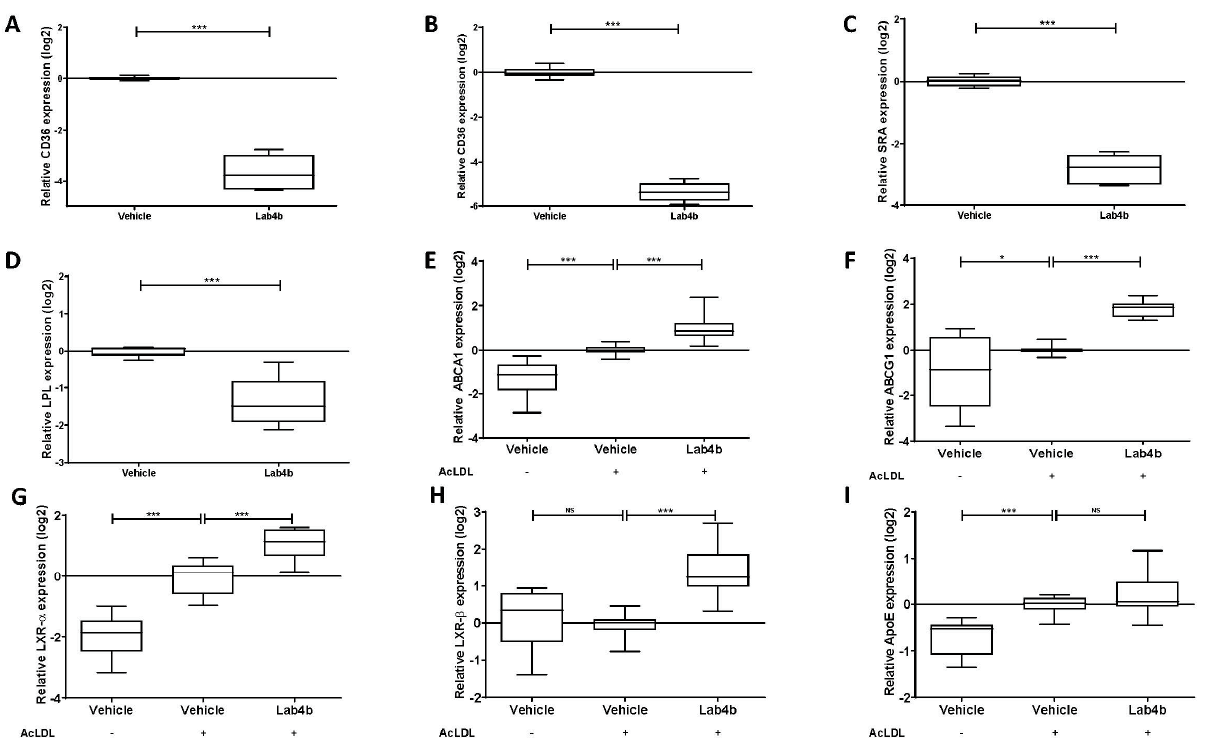
Figure 4. Lab4b CM regulates the expression of several key genes implicated in the control of macrophage foam cell formation. THP-1 macrophages ( A , C , D ), HMDM ( B ) or THP-1 macrophage- derived foam cells using acetylated LDL (AcLDL, 25 µ g/mL; E – I ) treatment for 24 h were incubated for 24 h with vehicle or Lab4b CM (1.5 µ g/mL). For THP-1 macrophage-derived foam cells ( F – I ), cells treated with vehicle alone in the absence any AcLDL treatment were also included for comparative purposes. The expression of CD36 ( A , B ), SRA ( C ), LPL ( D ), ABCA1 ( E ), ABCG1 ( F ), LXR- α ( G ), LXR- β ( H ), and ApoE ( I ) was determined on purified RNA by real-time quantitative PCR (RT- qPCR), as described in Materials and Methods, and normalised to the glyceraldehyde 3-phosphate dehydrogenase (GAPDH) housekeeping gene. The data are presented as box-and-whisker plots of log2 fold-change in gene expression relative to the vehicle control, where whiskers represent minimum-to-maximum fold-change from three independent experiments. Statistical analysis was performed using an unpaired Welch’s t -test ( A , C , D ), an unpaired Student’s t -test ( B ) or one-way ANOVA with the Bonferroni post-hoc test ( E-I ) (*, p ≤ 0.05; ***, p ≤ 0.001; NS, not significant).